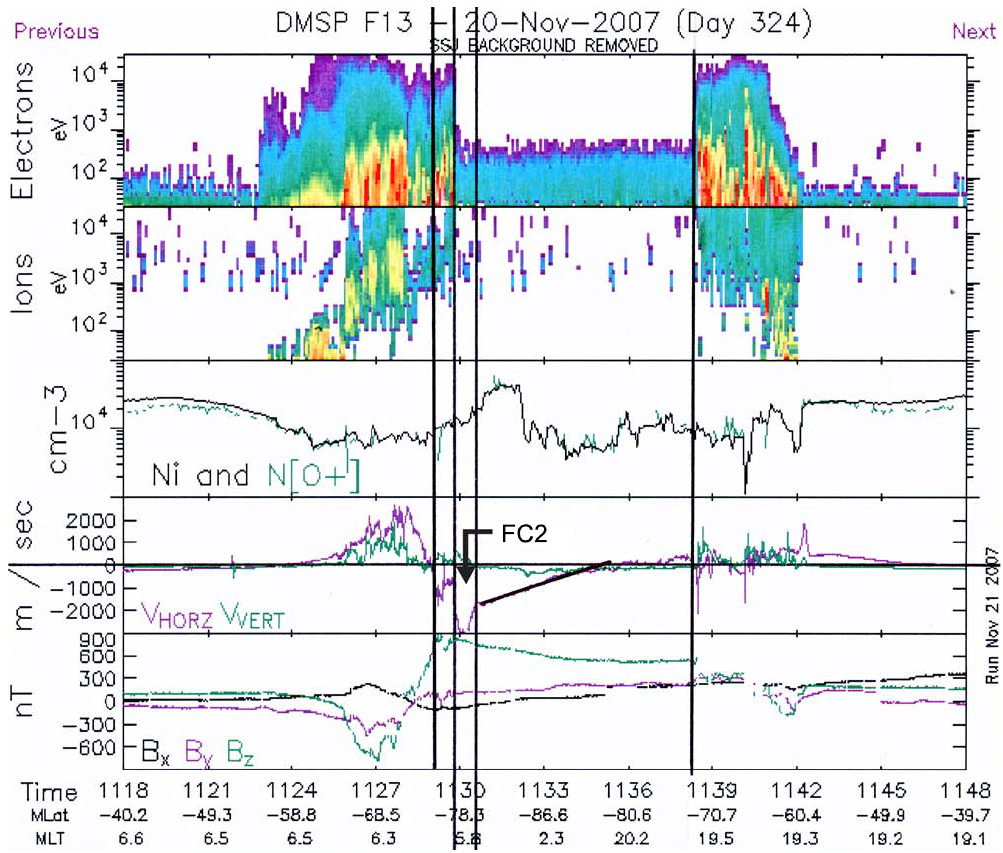
Fig. 14. DMSP data obtained by spacecraft F13 in the Southern Hemisphere during the interval 11:18–11:48UT on 20 November 2007. Same format as in Fig. 7. Flow channel FC 2 of category SH-dawn/ B y < 0 is